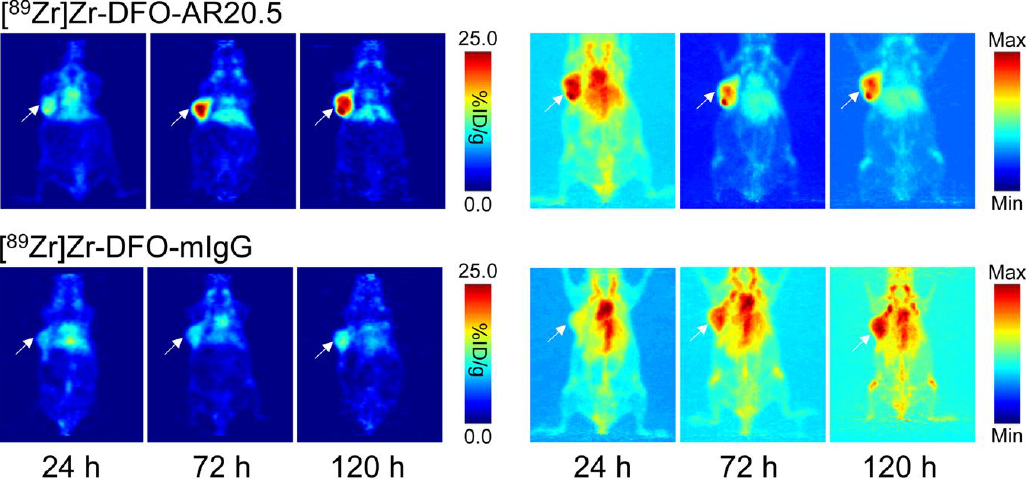
Figure 2. Planar (left) and maximum intensity projection (right; scaled to a minimum of 0% and a maximum of 100%) positron emission tomography (PET) images of representative athymic nude mice bearing subcutaneous SKOV3 xenografts collected at 24, 72, and 120 h following the intravenous tail vein injection of [ 89 Zr]Zr-DFO-AR20.5 or [ 89 Zr]Zr-DFO-mIgG. The white arrows mark the tumors.